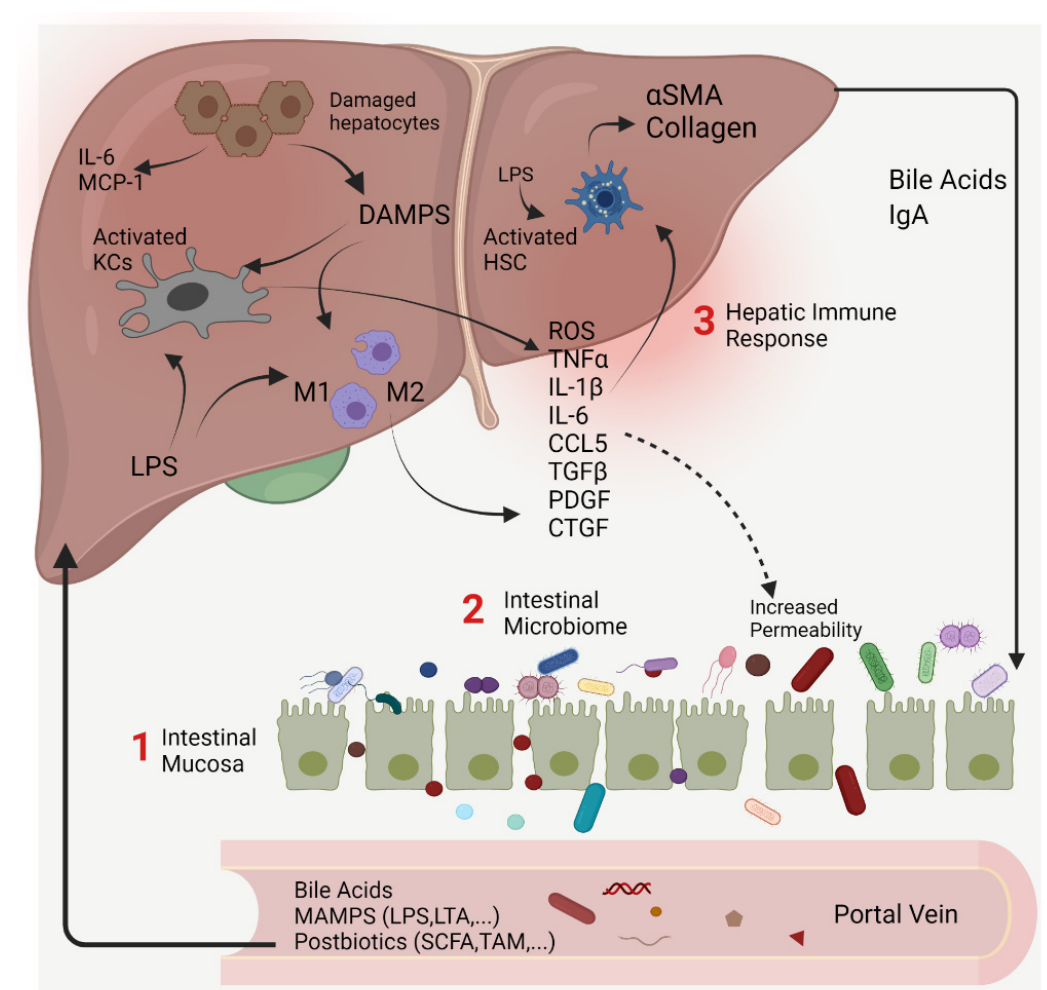
Figure 1. The gut–liver axis and its intersection with the intestinal microbiome as a potential therapeutic target for the treatment of liver fibrosis and portal hypertension. The bidirectional relationship between the gut, its microbiome and liver is established via the portal vein which transports immunogenic antigens from the gut. Conversely, the liver feedback route is via bile and antibody secretion in the gut. Our current understanding of the many etiologies of liver diseases is underpinned by intestinal dysbiosis, functional impairment of intestinal barrier, and systemic dissemination of gut MAMPs that trigger an abnormal immune-inflammatory cascade in the liver. Activation of HSCs into proliferative, fibrogenic myofibroblasts is well established as the central driver of hepatic fibrosis. Therapeutic interventions developed or undergoing clinical trials target elements of gut- liver interaction primarily the (1) intestinal mucosa, (2) microbiome and (3) diverse repertoire of immune cell populations in the liver and their sensors. α -SMA, alpha smooth muscle actin; CTGF/CCN2, connective tissue growth factor; DAMPs, damage associated molecular patterns; HSCs, hepatic stellate cells; IgA, immunoglobulin A; IL-1 β , interleukin one beta; IL-6, interleukin six; CCL5, chemokine (C-C motif) ligand 5; HSCs, hepatic stellate cells; KCs, Kupffer cells; LPS, lipopolysaccharides; LTA, lipoteichoic acid; M1, macrophage type1; M2, macrophage type 2; MAMPs, microbe-associated molecular patterns; CCL2/MCP-1, chemokine (C-C motif) ligand 2/monocyte chemoattractant protein-1; PDGF, platelet-derived growth factor; ROS, reactive oxygen species; SCFA, short-chain fatty acids; TMA, trimethylamine; TGF β , transforming growth factor beta; TNF- α , tumor necrotizing factor alpha.